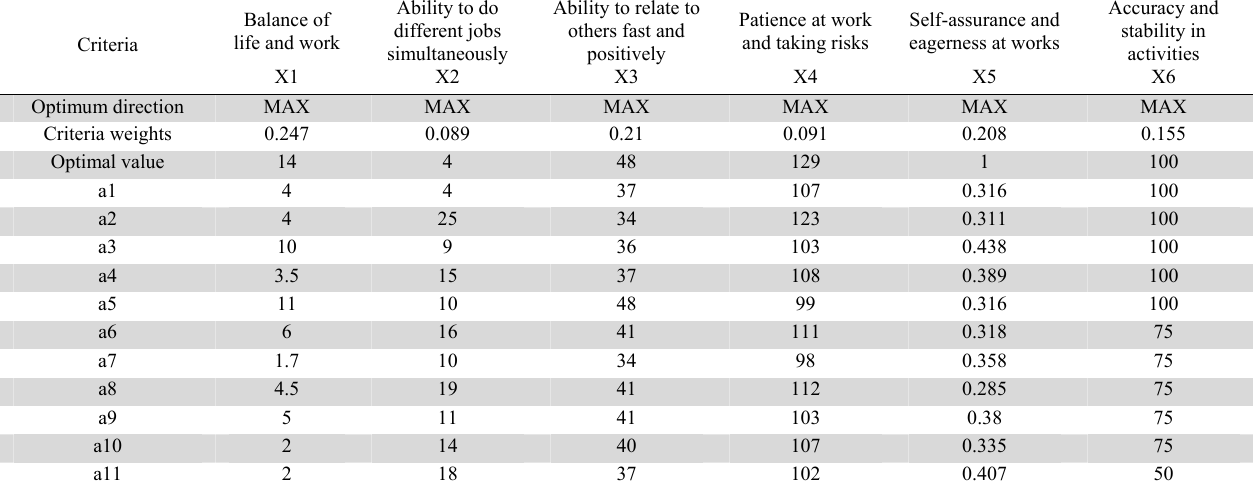
Decision-making